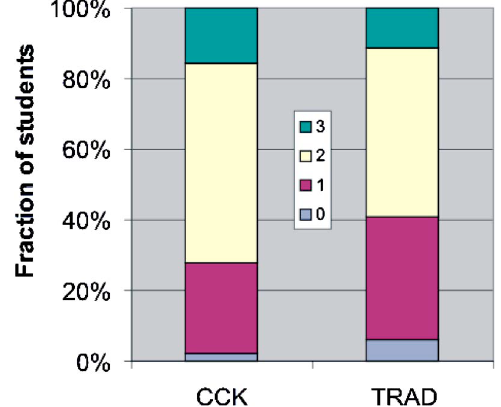
FIG. 4. (cid:1) Color (cid:2) Evaluation of student explanations of a circuit challenge using real equipment for students who had previously conducted a laboratory using simulations (cid:1) CCK (cid:2) or using real equipment (cid:1) TRAD